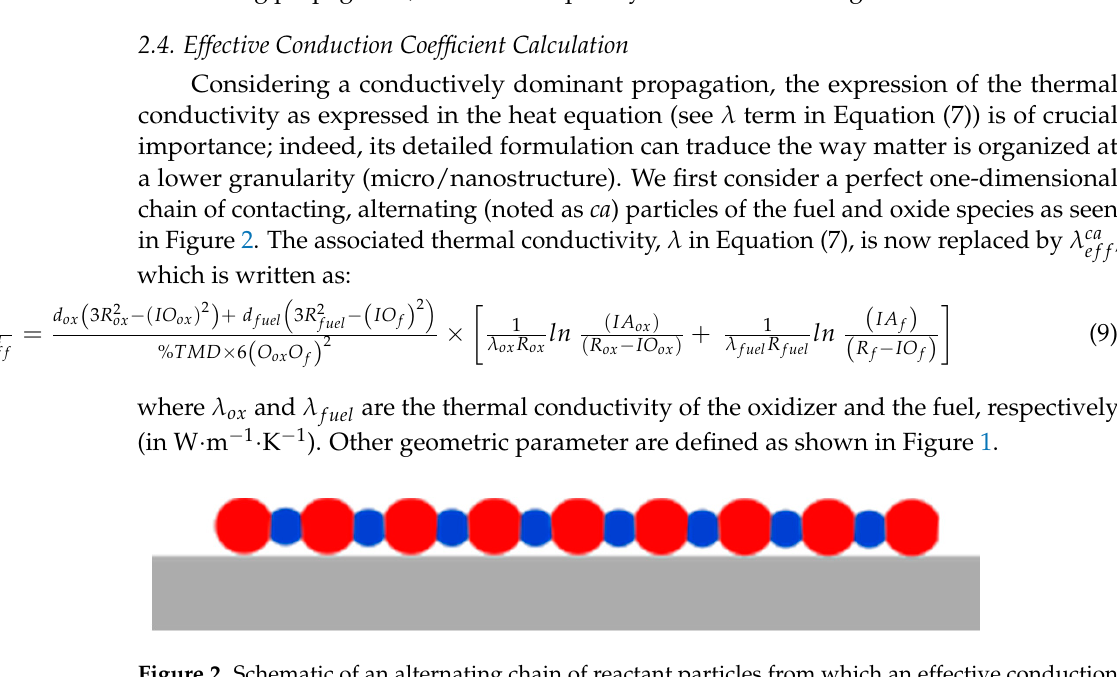
Figure 2. Schematic of an alternating chain of reactant particles from which an effective conduction coefficient is derived.